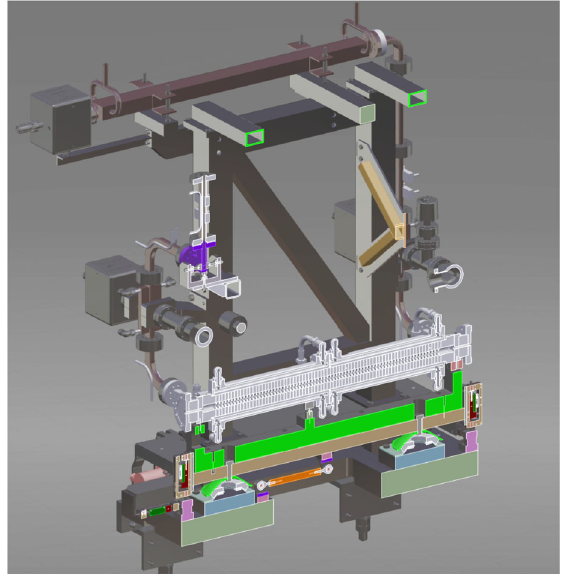
FIG. 22. Cutaway drawing of the X-band structure including waveguide system and motorized